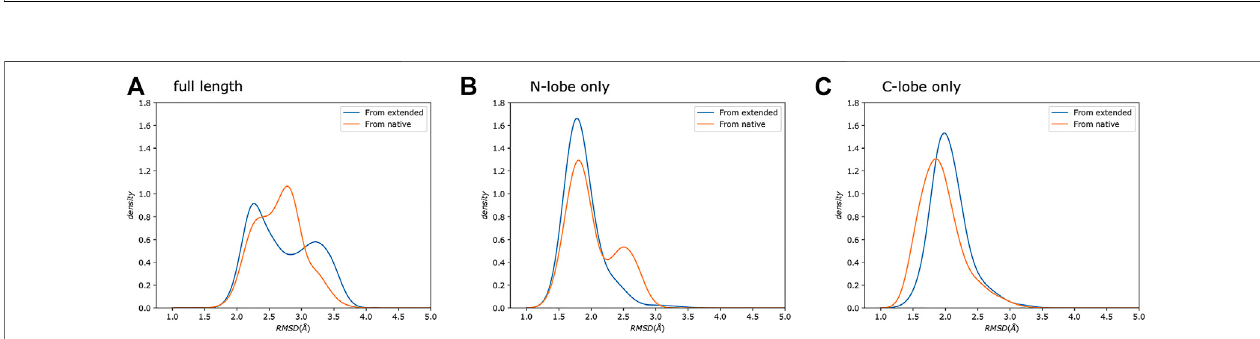
FIGURE 6 | Simulations from extended and native show similar distributions. We show a comparison of the same protocol started from either an extended chain (Trial3, blue) or from the reference crystal structure (Trial4, orange). Each panel shows the backbone RMSD compared to the reference crystal structure. We compare: (A) the full-length protein, as well as the (B) N-, and (C)